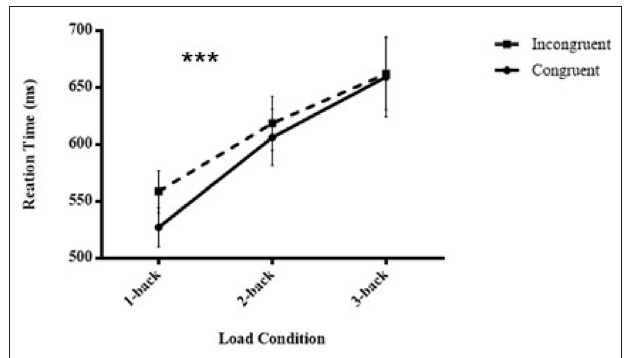
FIGURE 3 | Mean reaction times of unconscious visuomotor priming are illustrated as a function of executive attention load (1-back vs. 2-back vs. 3-back) and congruency conditions (congruent vs. incongruent) in Experiment 2. *** p < 0.001.